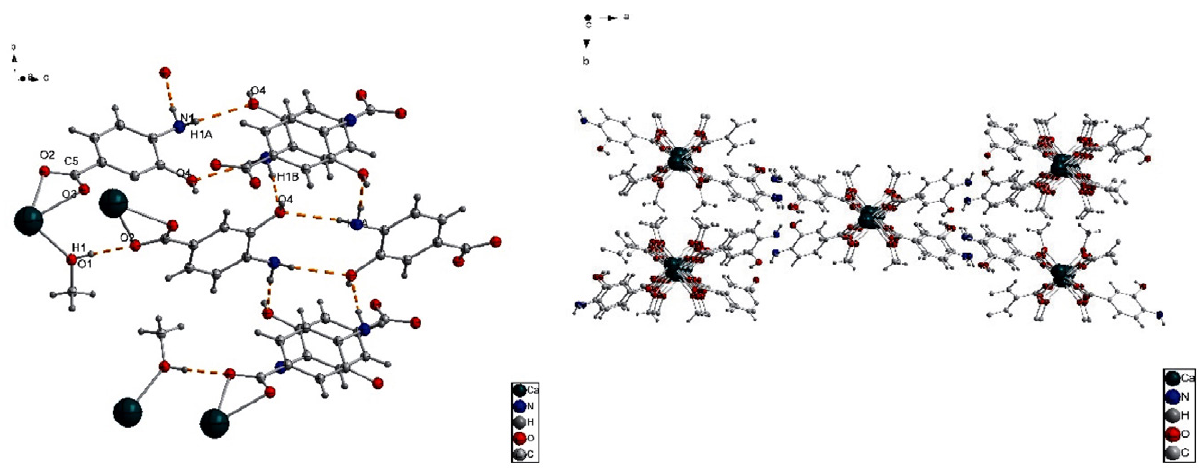
Figure 2. Structure of the calcium 4-amino-3-hydroxybenzoate showing the hydrogen bonding interactions (left) and packing diagram